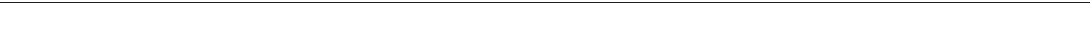
Fig. 4 Crucial role of CCR2 in the recruitment of circulating cDCs, pDCs and macrophages into the thymus. a Experimental setup: lethally irradiated CD45.1xCD45.2 WT recipients were reconstituted with BM cells from CD45.1 WT mice together with CD45.2 WT (WT donor group), CD45.2 Ccr2 RFP/RFP de fi cient ( Ccr2 RFP/RFP donor group), CD45.2 Ccr1 − / − ( Ccr1 − / − donor group) or CD45.2 Ccr5 − / − ( Ccr5 − / − donor group) mice (ratio 1:1). Thymic DCs